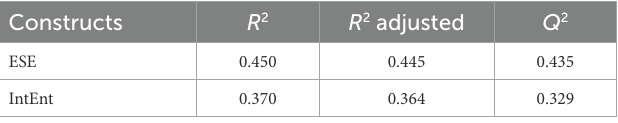
ESE, entrepreneurial self-efficacy; IntEnt, entrepreneurial intentions. TABLE 5 Convergent validity and reliability. Factors/ scales